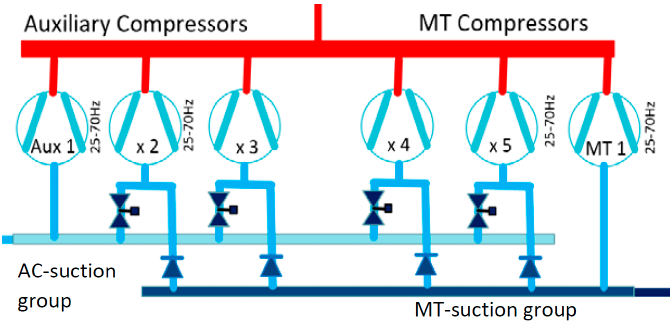
Figure 23. Schematic of the application of the “pivoting principle” to 4 out of 6 compressors [40].